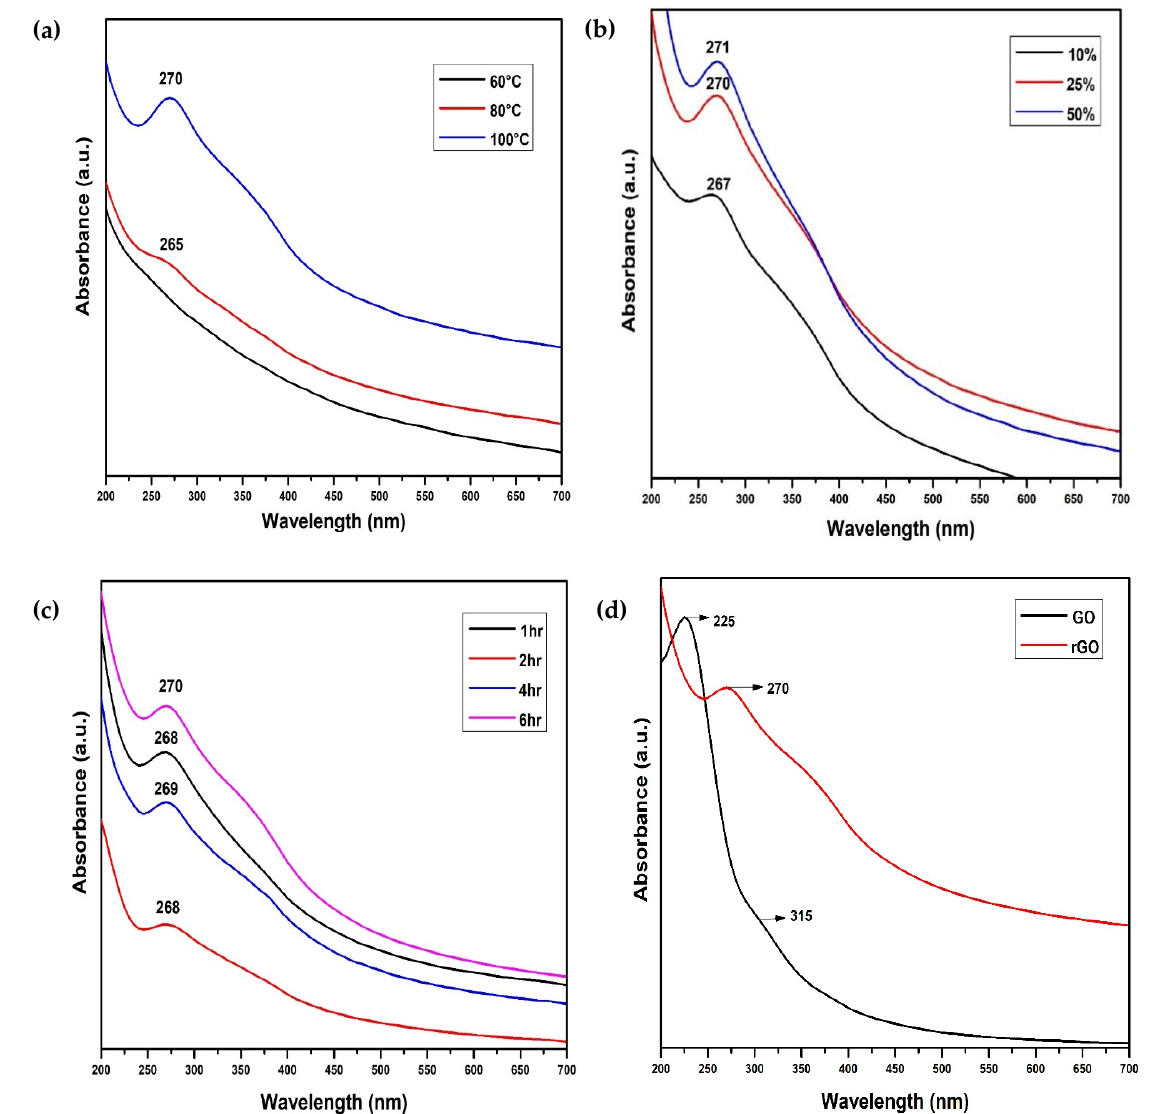
Figure 4. UV—Vis optical absorption spectrum of GO reduction at various ( a ) temperatures, ( b ) concentration of C. nutans leaf extract, ( c ) time, and ( d ) GO and rGO.